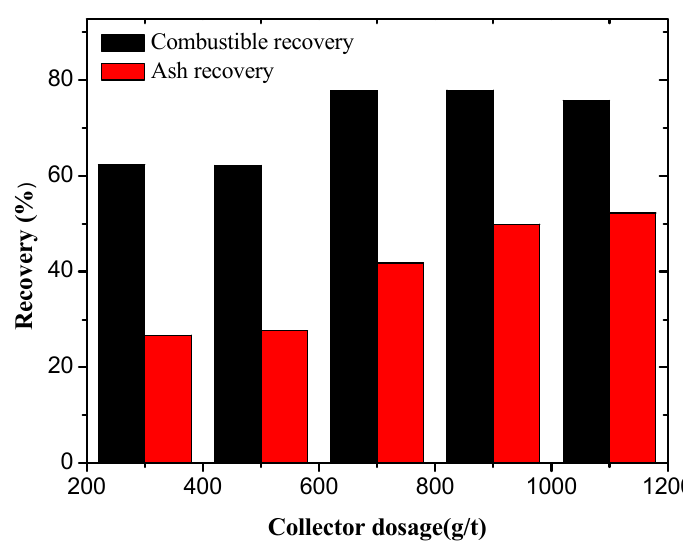
Figure 6. Oxidized coal flotation results using oleic acid.